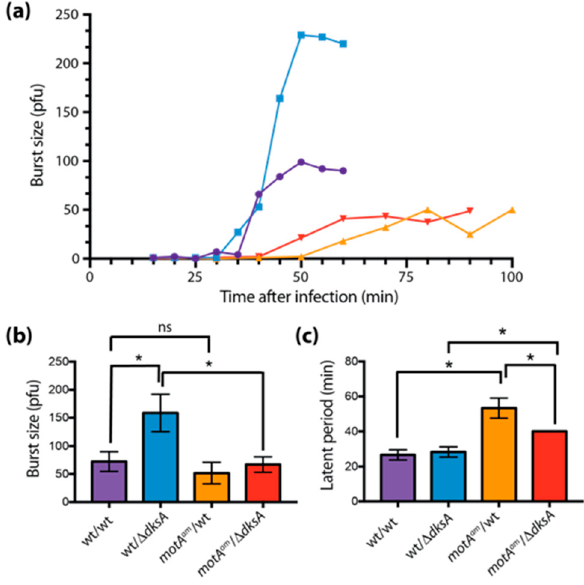
Figure 2. Absence of DksA increases the burst size of a T4 wt infection and decreases the latent period of a T4 motA am infection. ( a ) Representative graph of burst size vs. time after infection; ( b ) burst size, and ( c ) latent period for infections of T4 wt/B606 wt (purple), T4 wt/B606 ∆ dksA (blue), T4 motA am /B606 wt (orange), and T4 motA am /B606 ∆ dksA (red). Averages with indicated standard deviations were determined as described in Materials and Methods from three independent replicates. (The error bar on motA am / ∆ dksA is too small to be visible.) Asterisks (*) indicate significance as determined by an unpaired t test with a p value ≤ 0.05. The apparent 5 min difference in latent period of the wt/wt and wt/ ∆ dksA infection shown in ( a ) is not statistically significant (see panel ( c )).